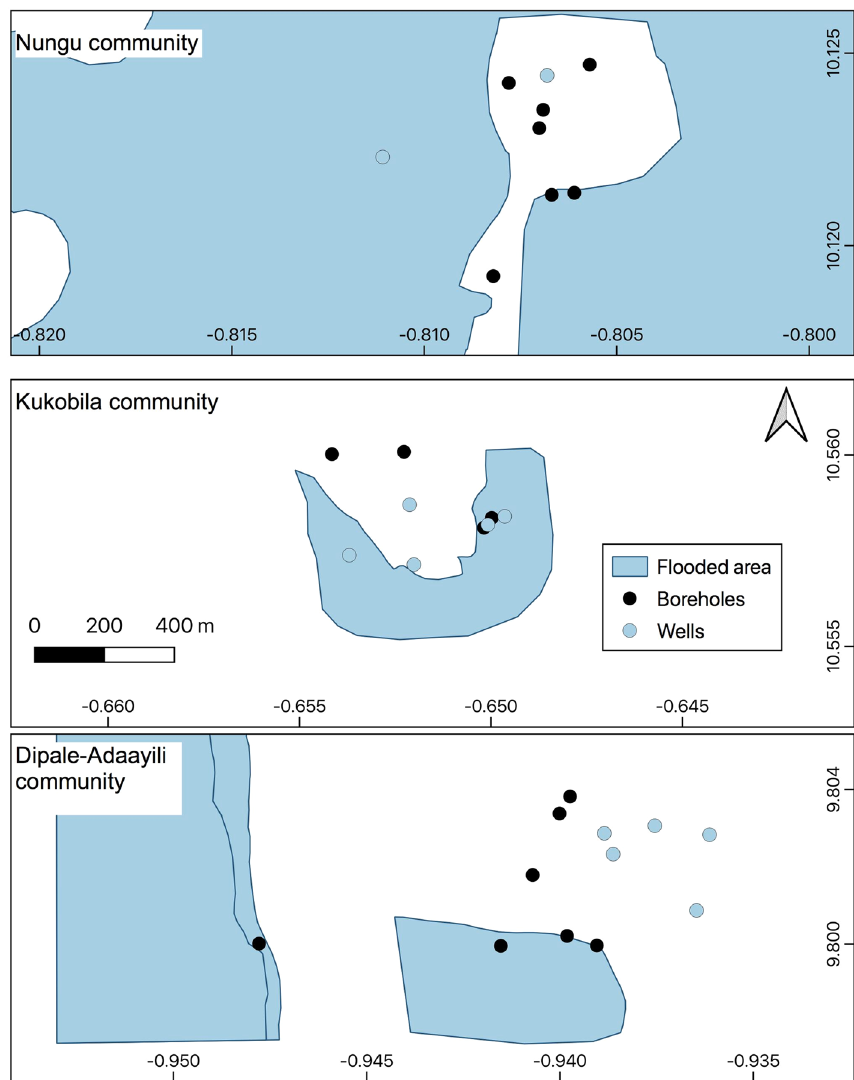
Fig. 2 Maps showing inundated areas, with water points in selected communities identified via participatory mapping with local political representatives from Talensi and Savelugu Municipality districts, northern Ghana (showing degrees of latitude and